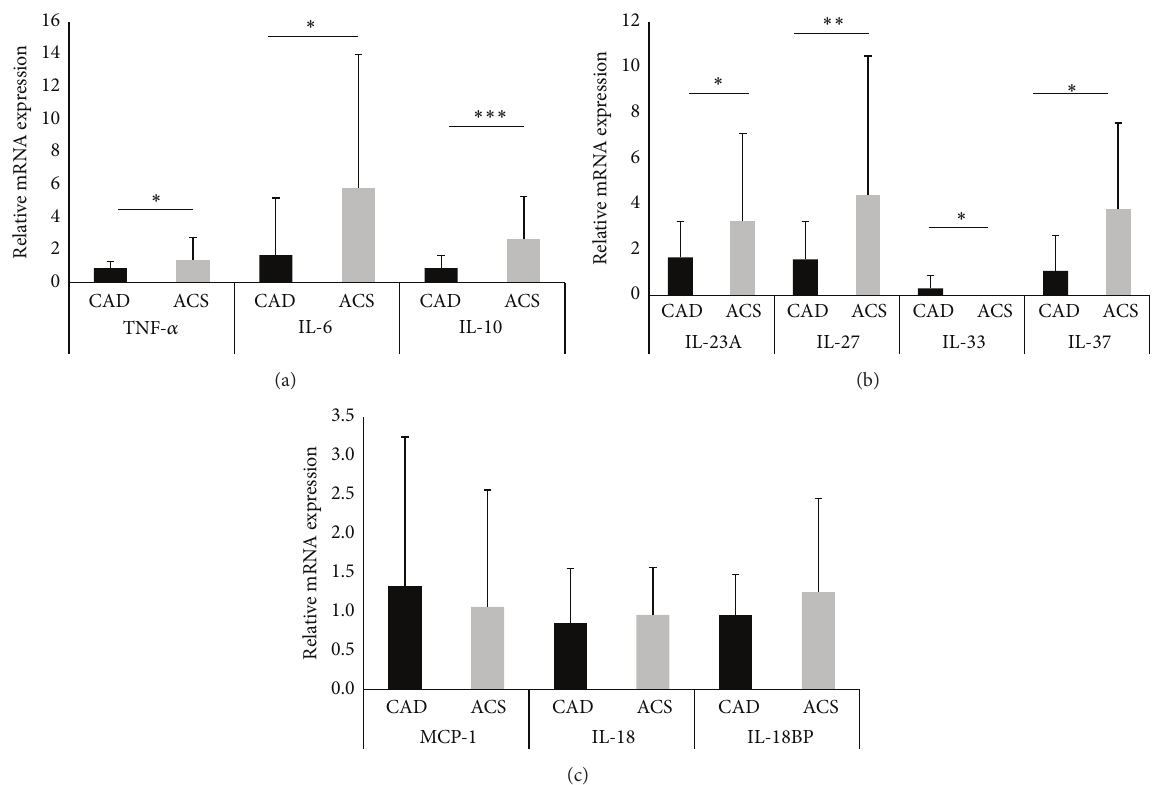
Figure 1: The data are presented as means ± SD. Profile of the expression levels of tumor necrosis factor- 𝛼 (TNF- 𝛼 ), interleukin- (IL-) 6, and IL-10 (a); IL-23A, IL-27, IL-33, and IL-37 (b); and monocyte chemoattractant protein-1 (MCP-1), IL-18, and IL-18 binding protein (BP) (c) in the coronary artery disease (CAD) and acute coronary syndrome (ACS) groups. ∗ 𝑃 < 0.05 ; ∗∗ 𝑃 < 0.01 ; ∗∗∗ 𝑃 < 0.001